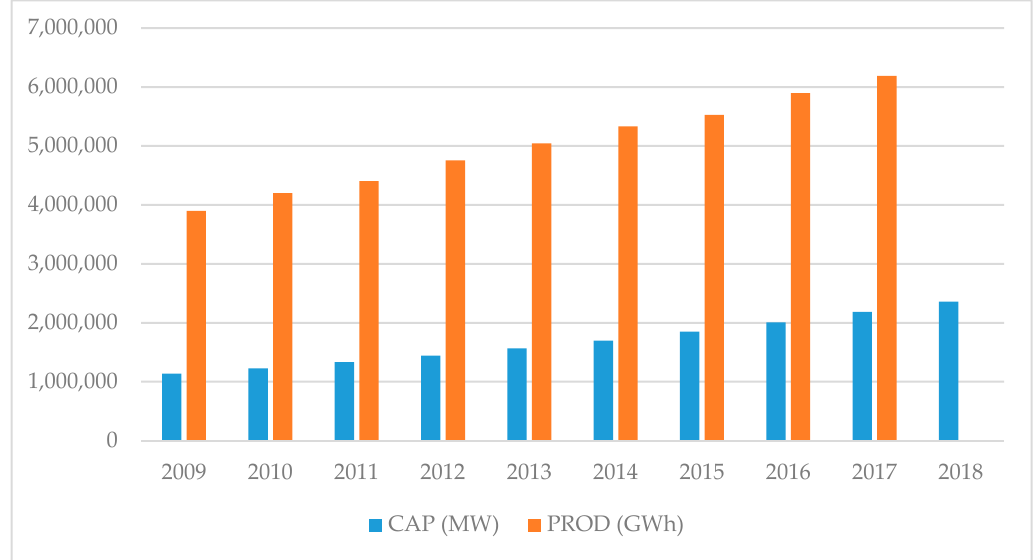
Figure 1. Total renewable energy capacity and production in the world. Source: authored based on The International Renewable Energy Agency data [3].